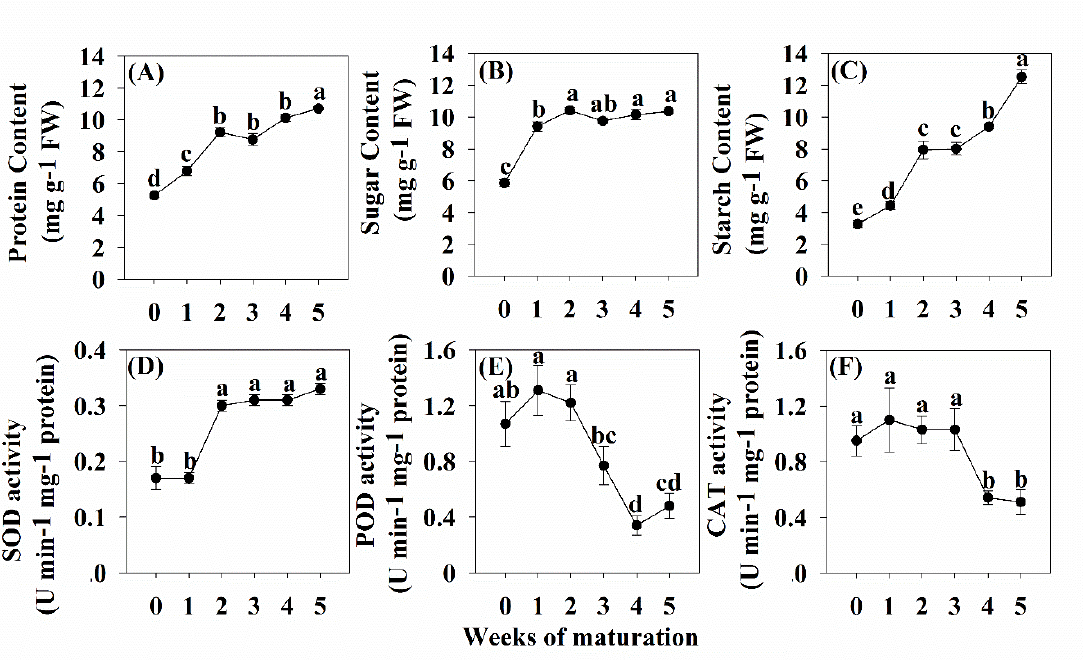
Figure 5. Physiological changes of somatic embryos of Korean pine in maturation medium at 0, 1, 2, 3, 4 and 5 weeks. ( A ) Sugar content, ( B ) Starch content, ( C ) Proline content, ( D ) SOD activity, ( E ) POD activity, ( F ) CAT activity. Different letters above the curve indicate significant differences between samples. (Duncan test; P = 0.05).